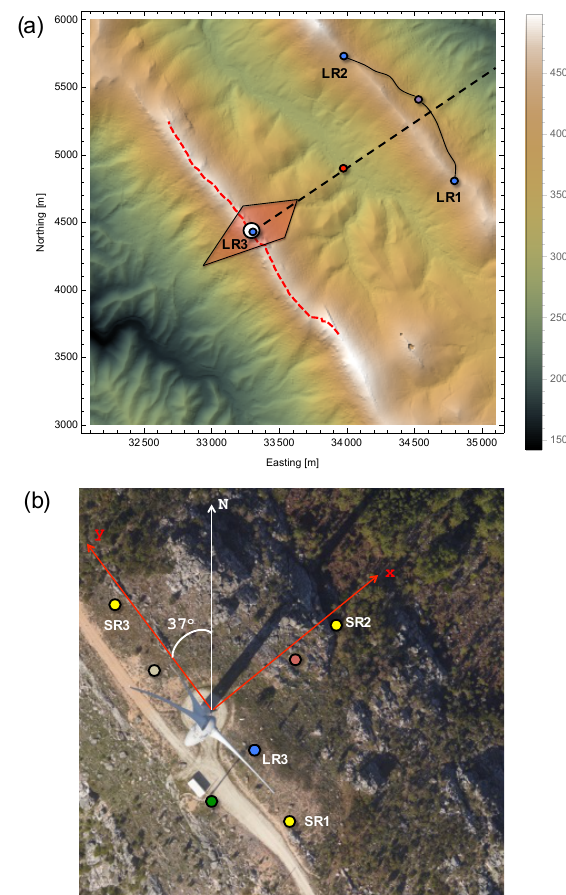
Figure 6. Perdigão site: (a) overall view (blue circles, long-range WindScanner units; white circle, wind turbine; pink quadrilateral, diamond scan; dashed black line, transect scan; red circle, virtual mast scan; solid black lines, power cables; red dashed line, ridge scan); (b) top view around the wind turbine (yellow circles, short- range WindScanner units; blue circle, long-range WindScanner unit LR3; grey circle, control center; red circle, calibration pole; green circle, telecom tower and substation). Figure 7. Calibration of the SRWS: (a) actual setup (1 – telecom